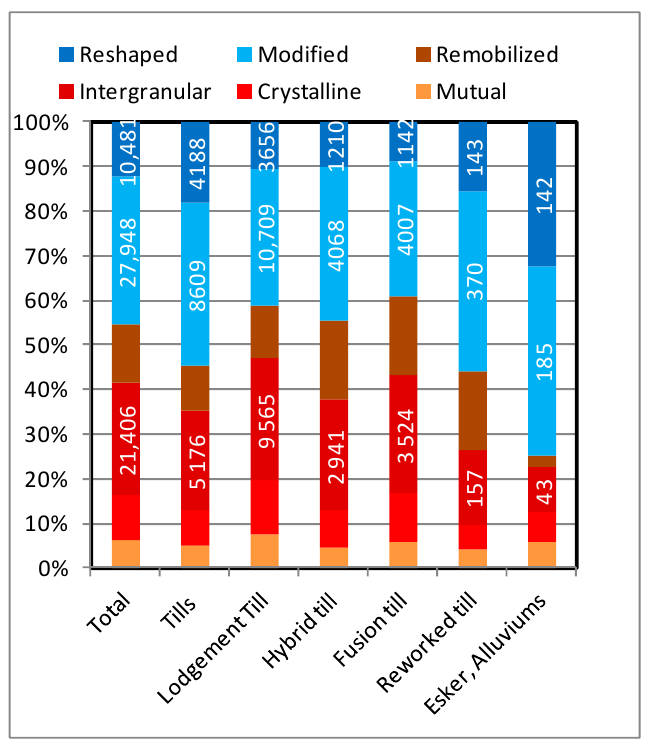
Figure 15. Proportion of the various morphofacies (reddish tints: pristine, blue: modified and re- shaped) according to sediment types. Lodgment, hybrid and fusion tills have very similar proportions (58% pristine) while reworked tills, esker and alluviums show a drastic increase in more rounded grains (modified and reshaped), caused by attrition during water-borne transport. Undifferentiated tills are a poorly described material, and may include a variety of sediment types. Numbers indicated inside the bars are the grain counts of the specific class.